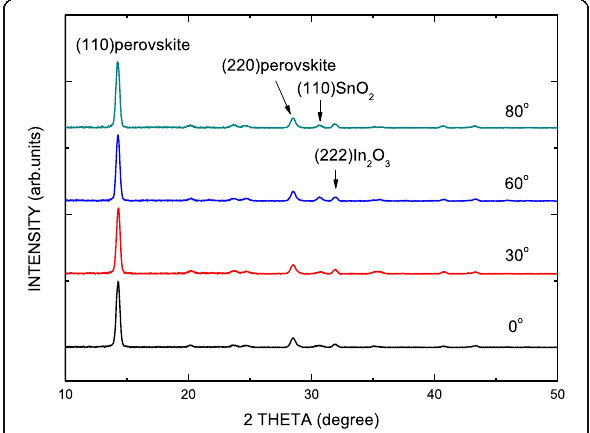
Fig. 2 XRD patterns of MAPbI 3 perovskite films on PEDOT:PSS/oblique ITO layer/glass for various oblique